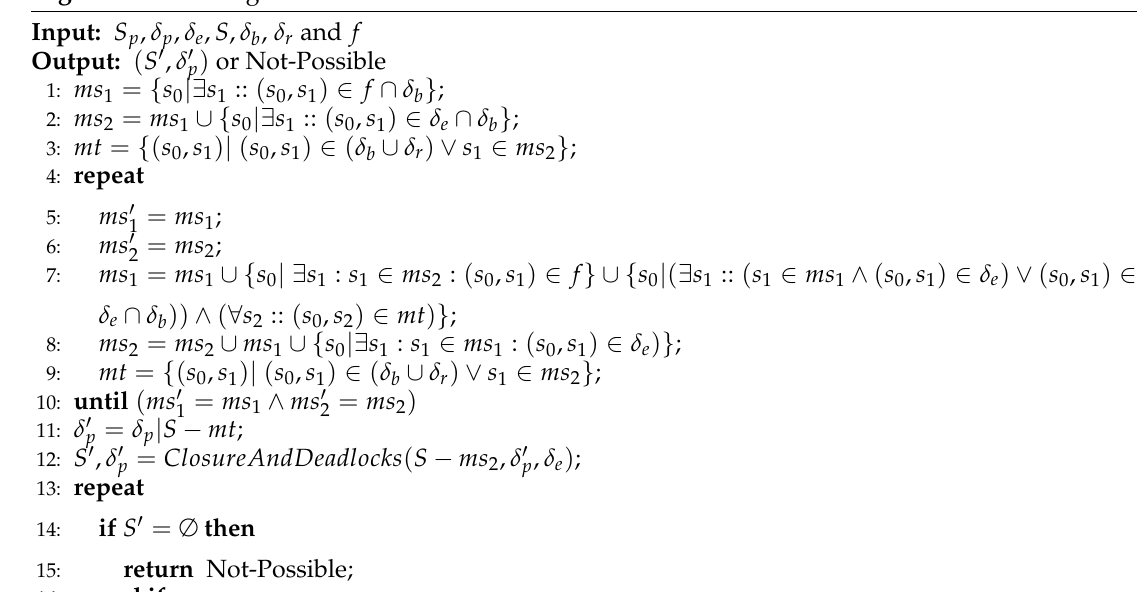
Algorithm 2 Adding Failsafe